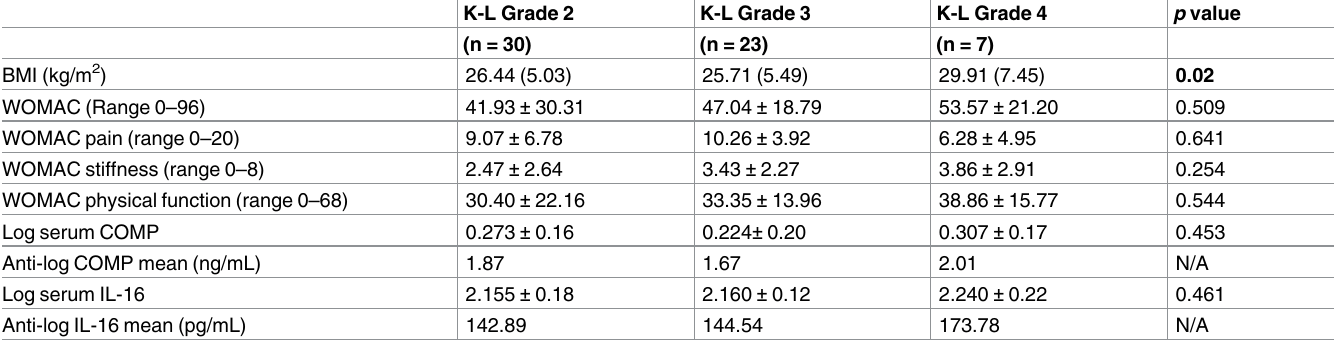
Table 2. Comparison between the kellgren-lawrence grades of knee